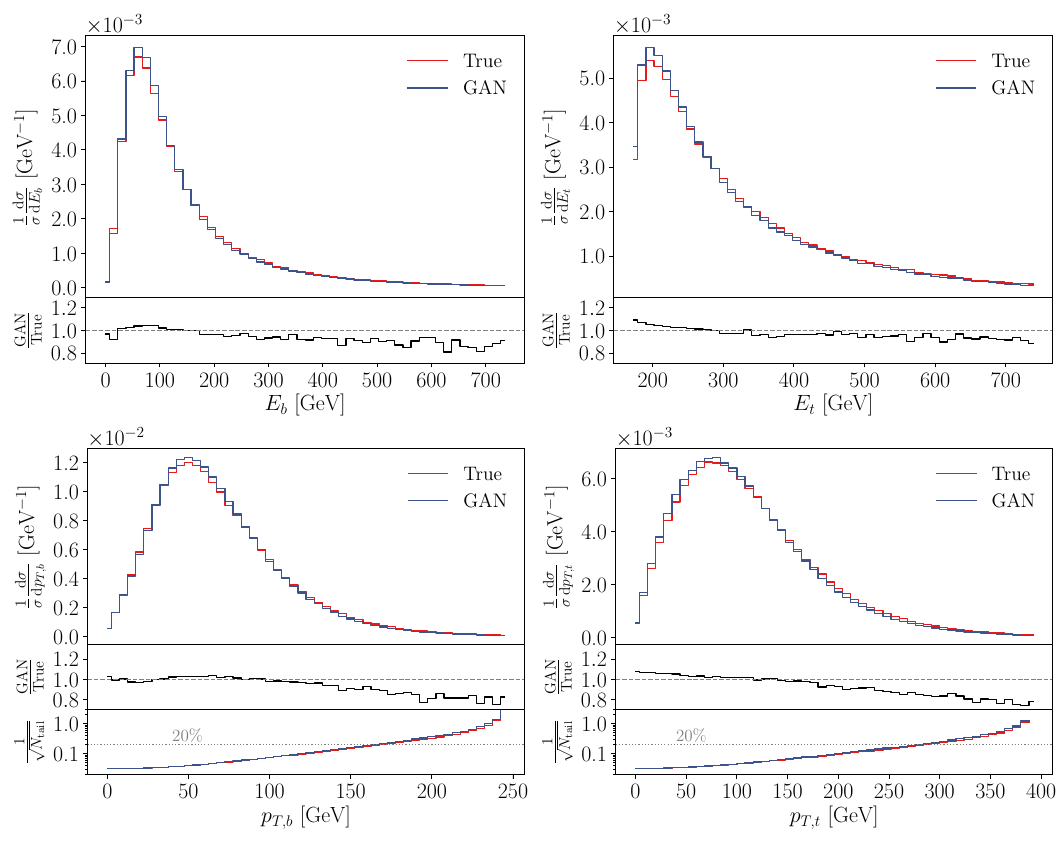
Figure 4: Energy (top) and transverse momentum (bottom) distributions of the final- state b -quark (left) and the decaying top quark (right) for MC truth (blue) and the GAN (red). The lower panels give the bin-wise ratio of MC truth to GAN distribution. For the p distributions we show the relative statistic uncertainty on the cumulative T number of events in the tail of the distribution for our training batch